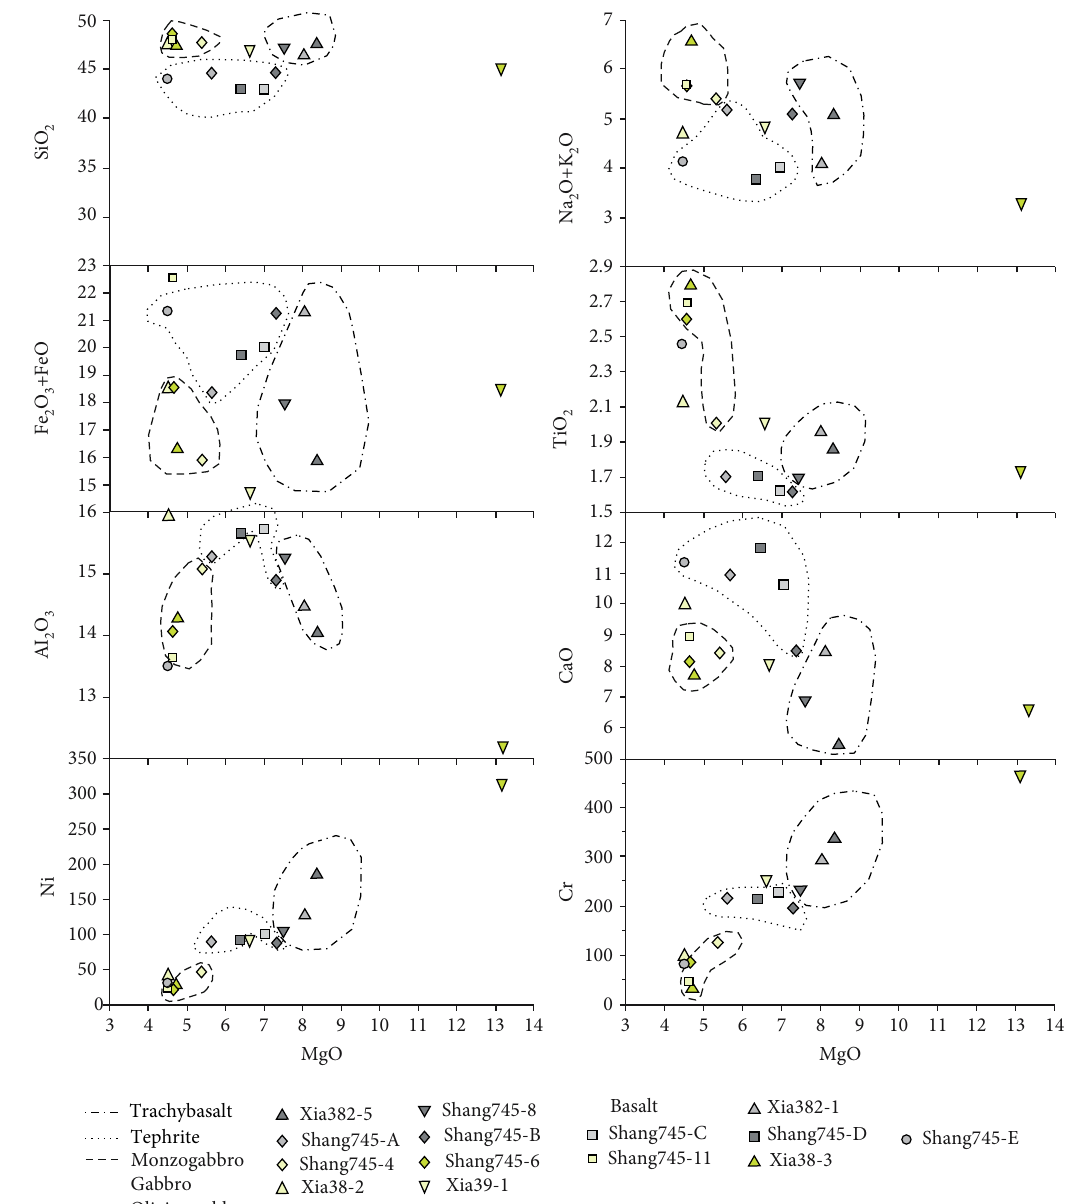
Figure 6: Various oxides and Cr, Ni plotted against MgO for the Paleogene igneous rocks in Huimin Sag with literature data for